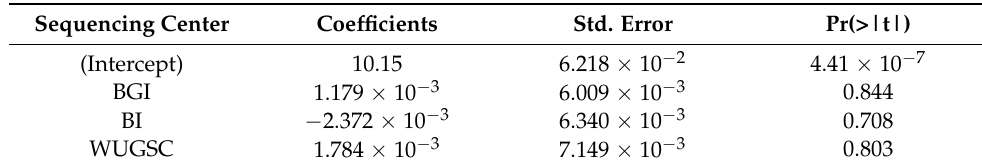
Table 5. Coefficient, standard error, and p value of the coefficient from the hierarchical mixed model using the log(number of inferred archaic introgressed alleles) as defined by [4] and the sequencing center of the samples as the dependent variable. For this analysis, we only considered sequencing centers that sequenced samples across all populations.